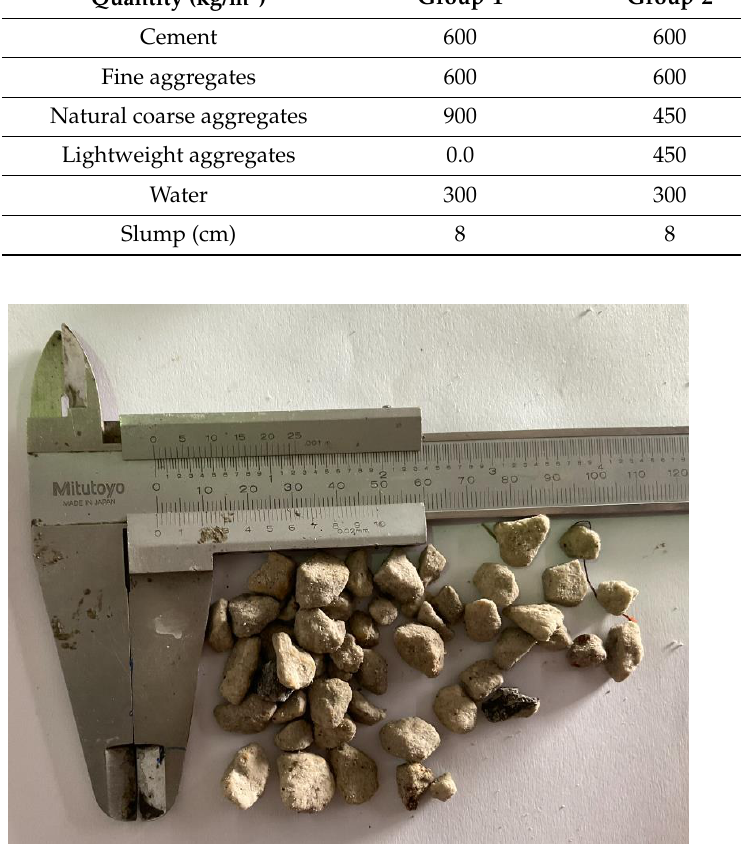
Figure 1. Lightweight aggregates.